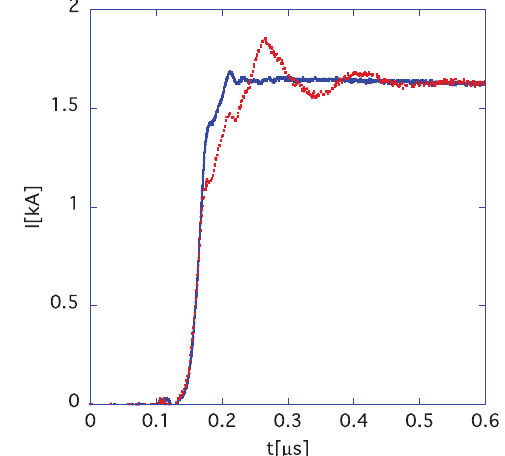
FIG. 7. Measurements of rising edge of the pulse current provided by PFL at the position A in Figs. 1 and 5. The red dotted and the blue solid lines show the results with and without diode and 10 Ω resistor, respectively.